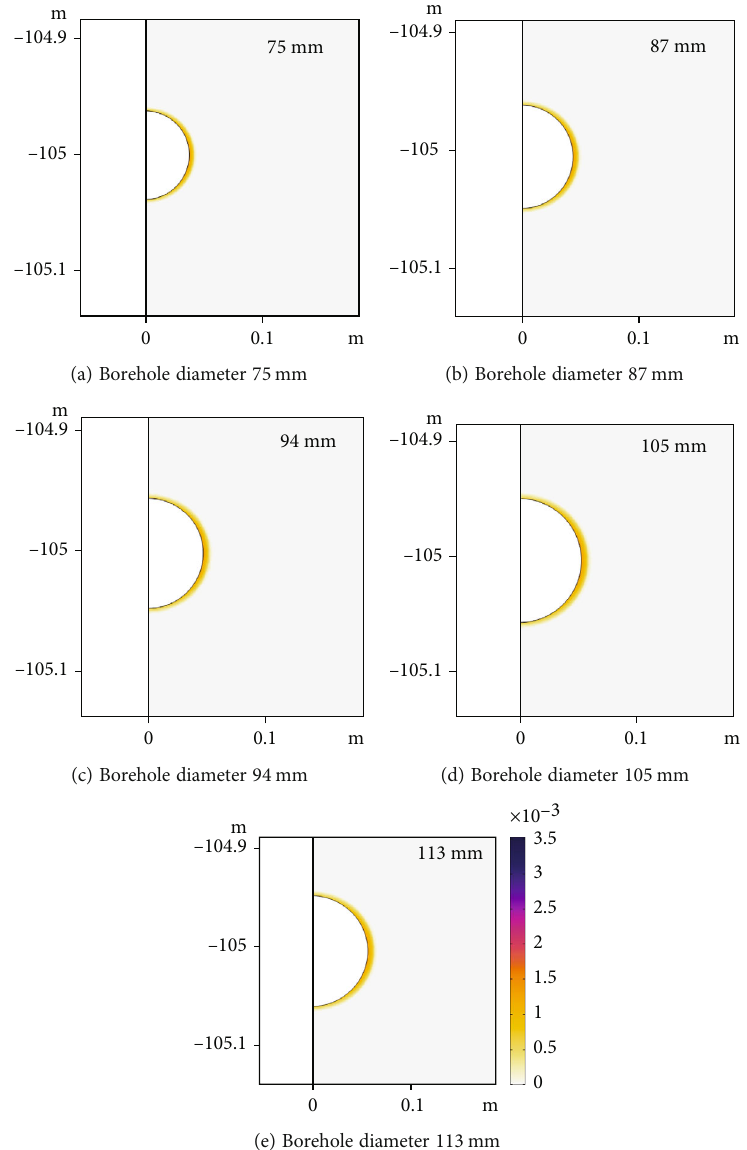
Figure 4: Plastic zone of di ff erent pore